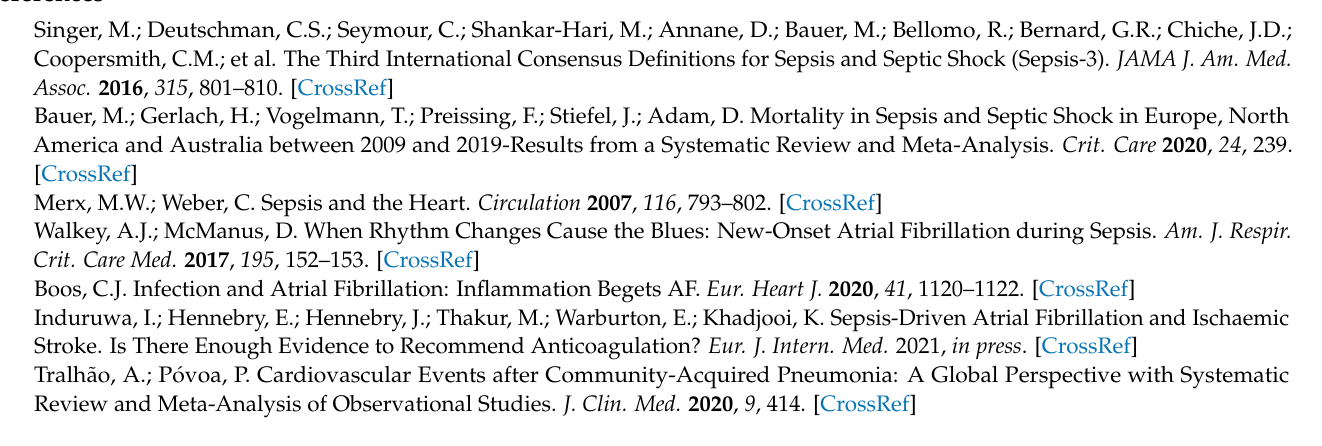
Figure S2: Leave one out analysis for NOAF Prevalence; Figure S3: Cumulative Meta-Analysis of Prevalence of NOAF based on Study Publication Year.; Figure S4: Leave one out analysis